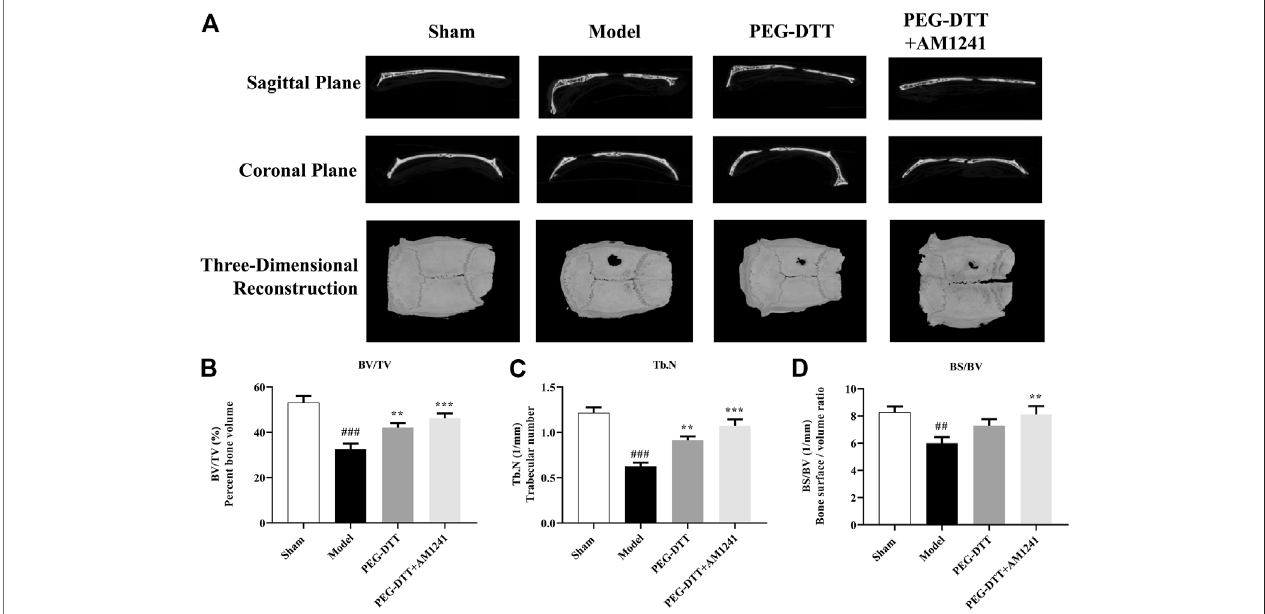
FIGURE 4 | Micro-CT images and bone-related indexes. (A) Sagittal images, coronal images, and three-dimensional reconstruction of micro-CT scans from different groups. (B) Bone volume per total volume (BV/TV, %). (C) Trabecular number (Tb.N, 1/mm). (D) Bone surface per volume ratio (BS/BV). Compared with the Sham group, ## p < 0.01, ### p < 0.001; compared with the model group, ** p < 0.01, *** p < 0.001.